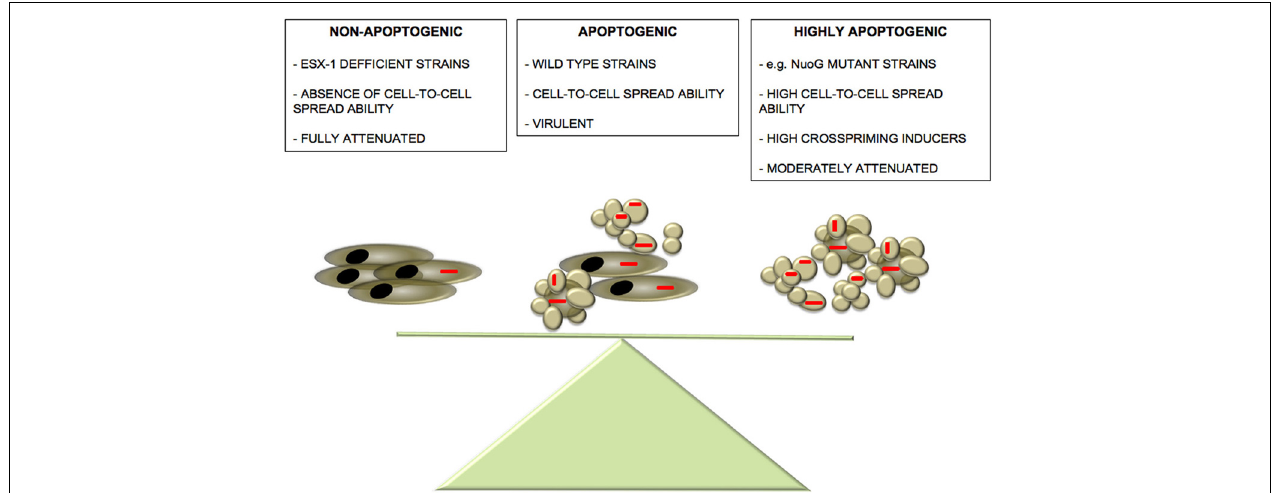
FIGURE 1 | Balance between M. tuberculosis -induced apoptosis and virulence. We propose the existence of a delicate balance between mycobacteria-induced apoptosis and pathogenesis. Absence of apoptosis observed in ESX-1-deficient strains leads to a sound attenuation phenotype accompanied by abrogated cell-to-cell spread capacity (Aguilo et al., 2013). On the other hand, although highly apoptogenic strains show an increased cell-to-cell spread capacity compared to wild-type strains, they might present